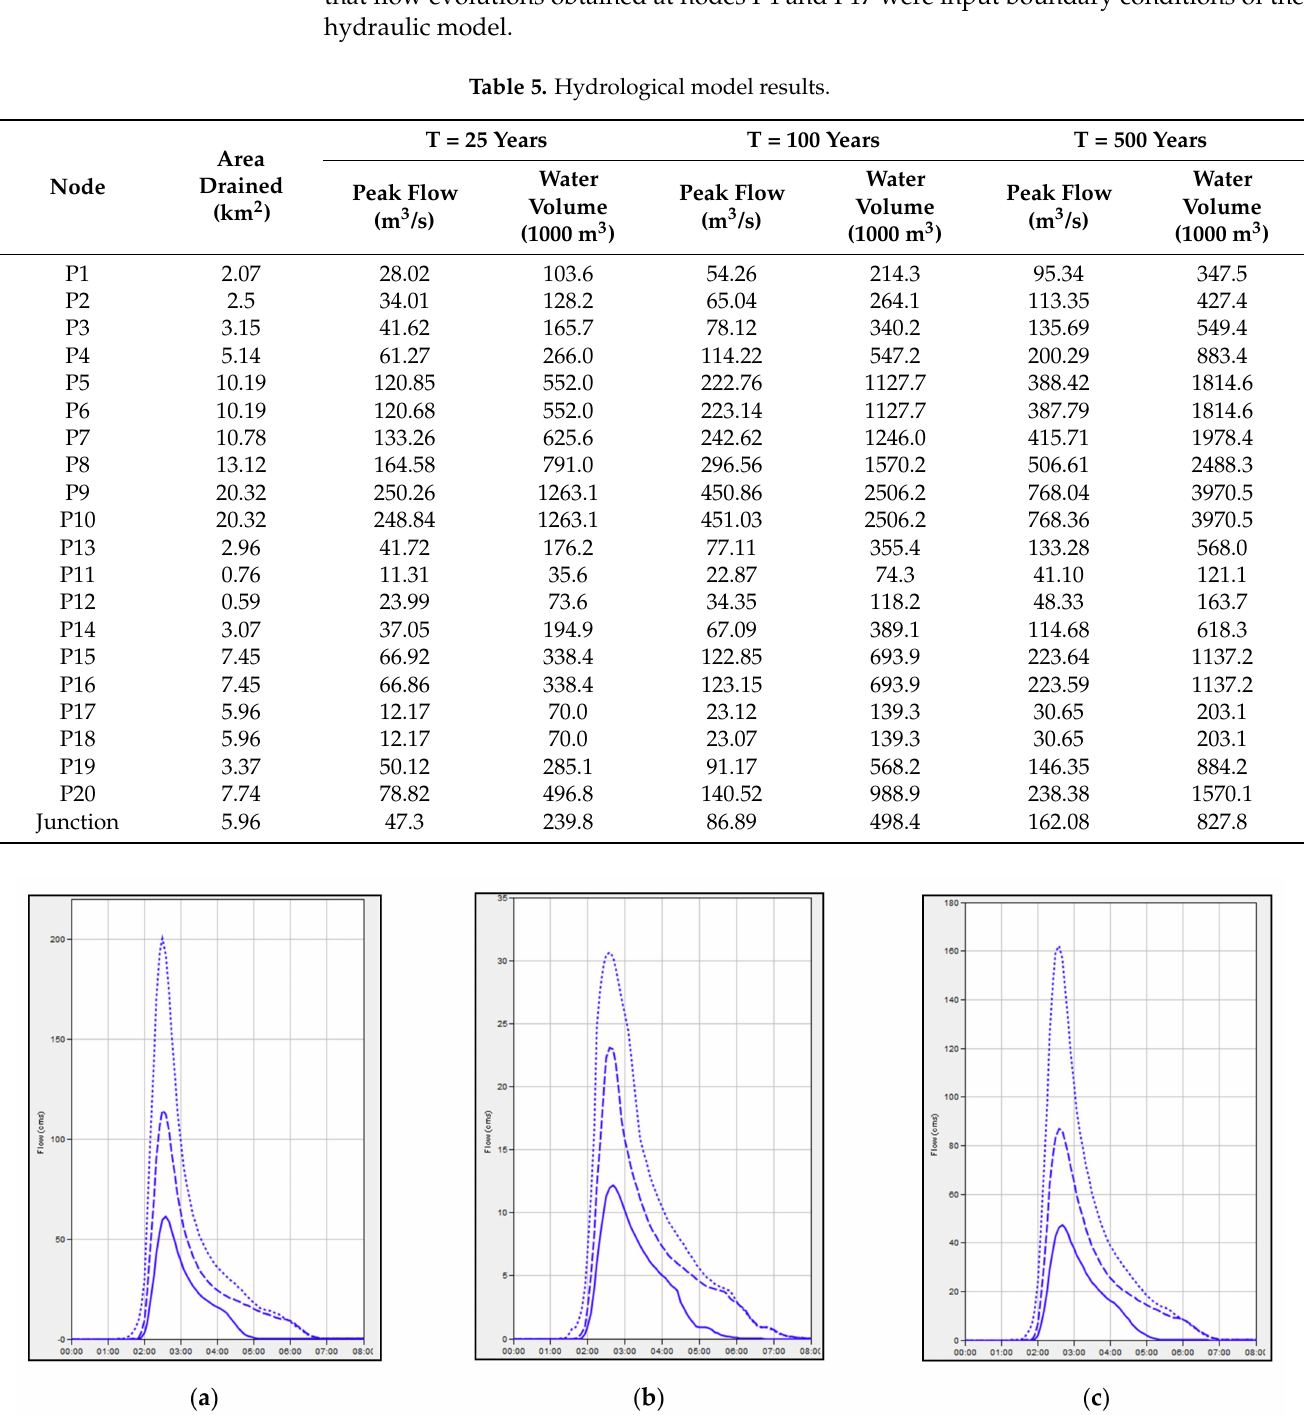
Figure 10. Hydrographs at nodes located next to the highway: ( a ) P4 node; ( b ) P17 node; ( c ) Junction node upstream P17. Vertical axis: flow. Horizontal axis: time. Continuous, dashed and dotted lines corresponds to the return periods T = 25 years, T = 100 years and T = 500 years,